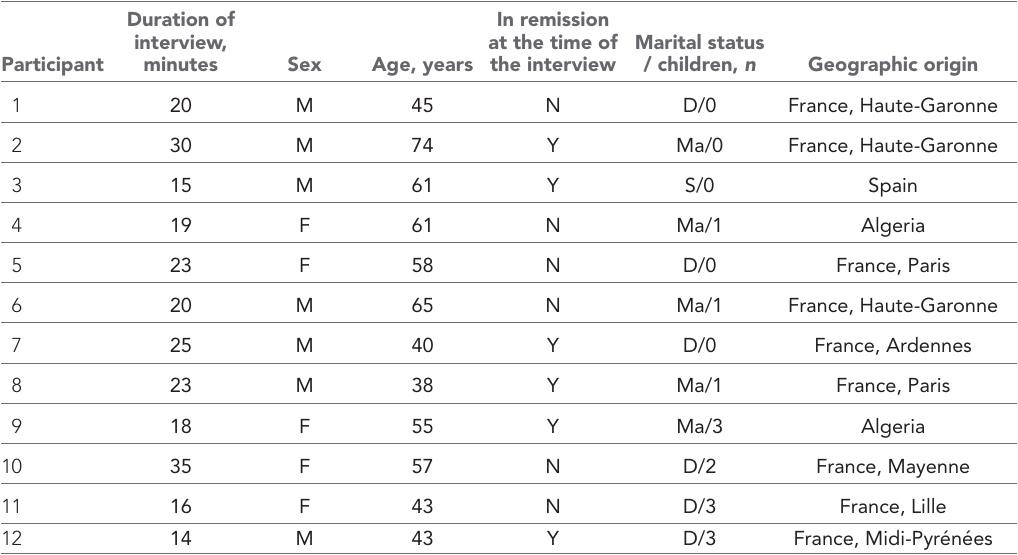
Table 1 Participant